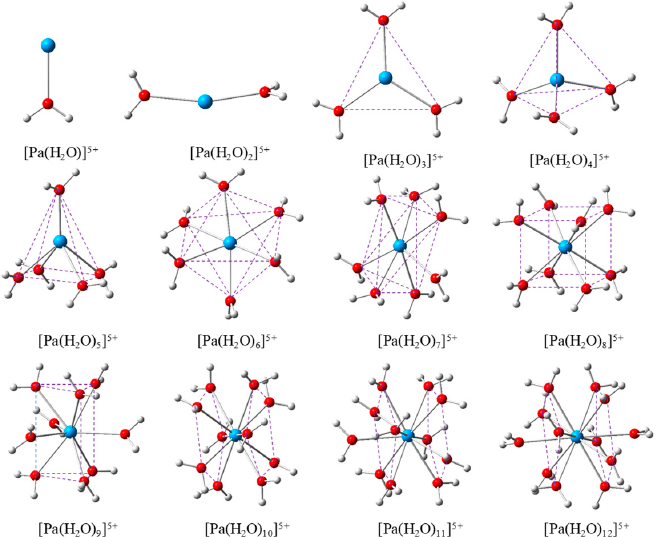
Figure 1. Optimized geometries of [Pa(H 2 O) n ] 5+ (n=1-12) calculated with B3LYP/GEN/IEF-PCM level of theory (GEN: SDD for Pa and 6-311G (d, p) for H & O atoms, and IEF-PCM denotes Integral Equation Formalism Polarizable Continuum Model). The blue, red, and white balls denote Pa, O, and H atoms, respectively.